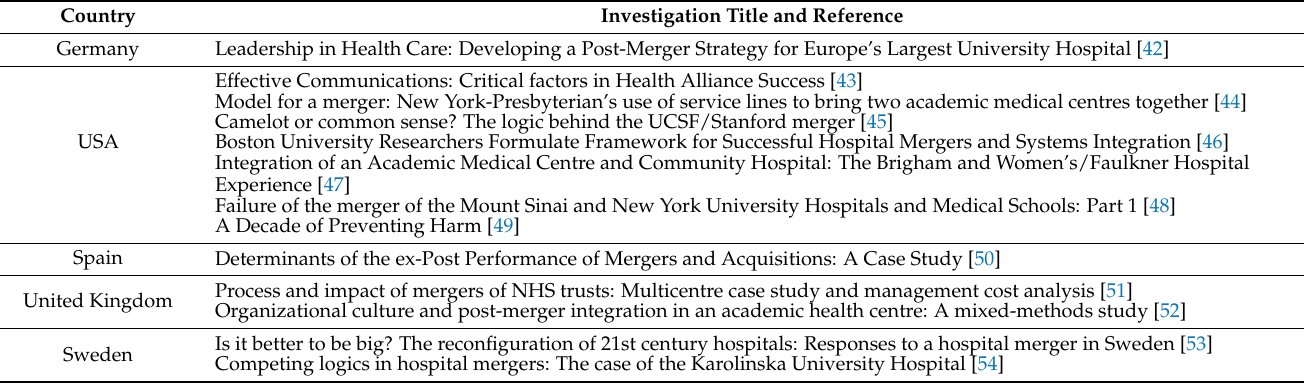
Table 1. Selected studies